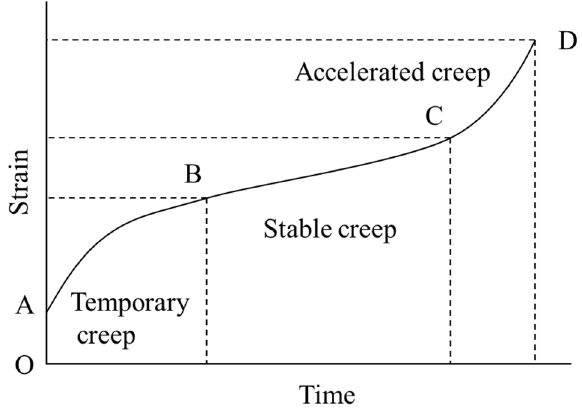
Figure 2. Typical creep curve of rock.